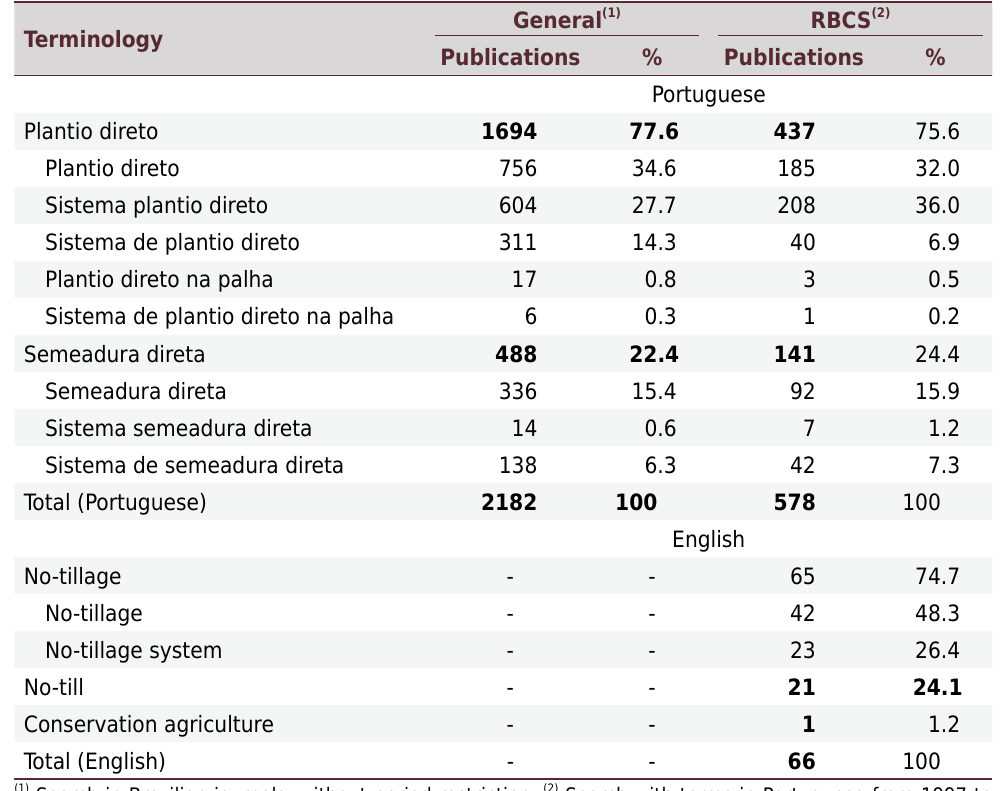
Table 1. Number and percentage of use of the terms “Plantio Direto,” “Semeadura Direta,” and variations in scientific publications available online in Brazilian journals, and specifically in